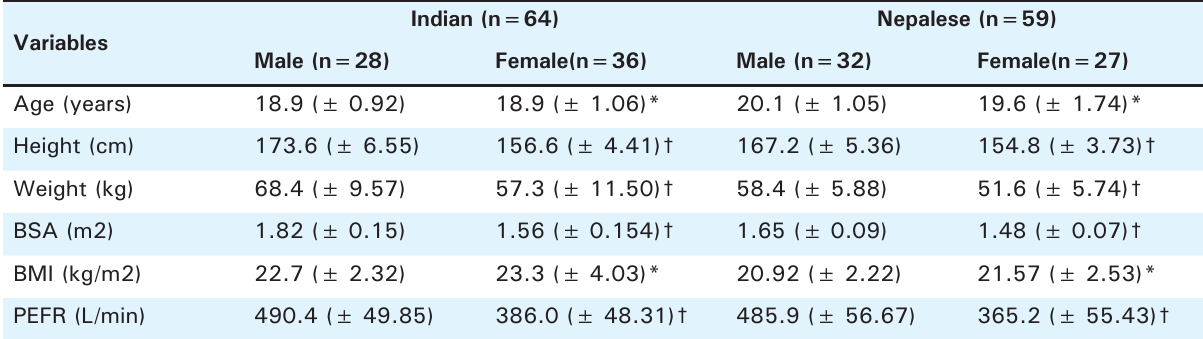
Table 2. Comparisons of physical characteristic including PEFR of the male and female young adults of India and Nepal